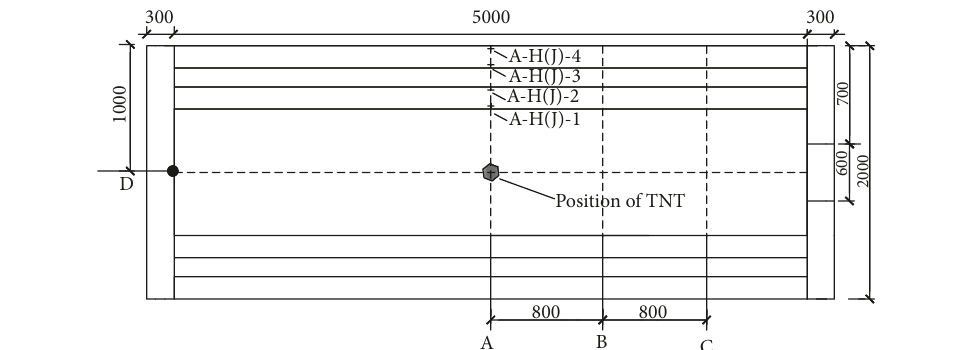
Figure 6: Position of strain measurement points.